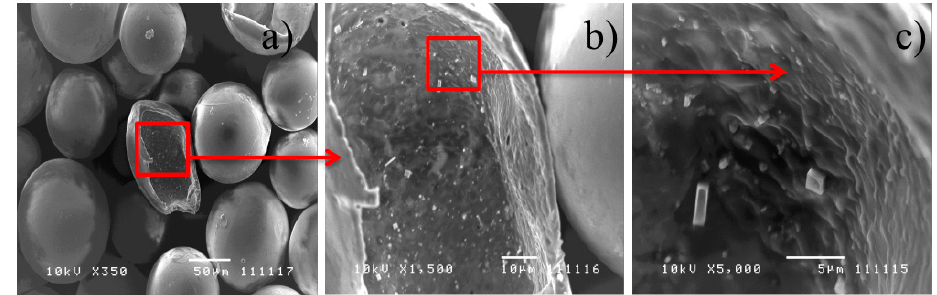
Figure 2. SEM images of ( a ) cross-section of microcapsule, ( b ) distribution of NPs encapsulated, and ( c ) zoomed-up image of NPs (Chitosan coated alginate NPs). Red square and arrow mean zoomed-up area of previous image.